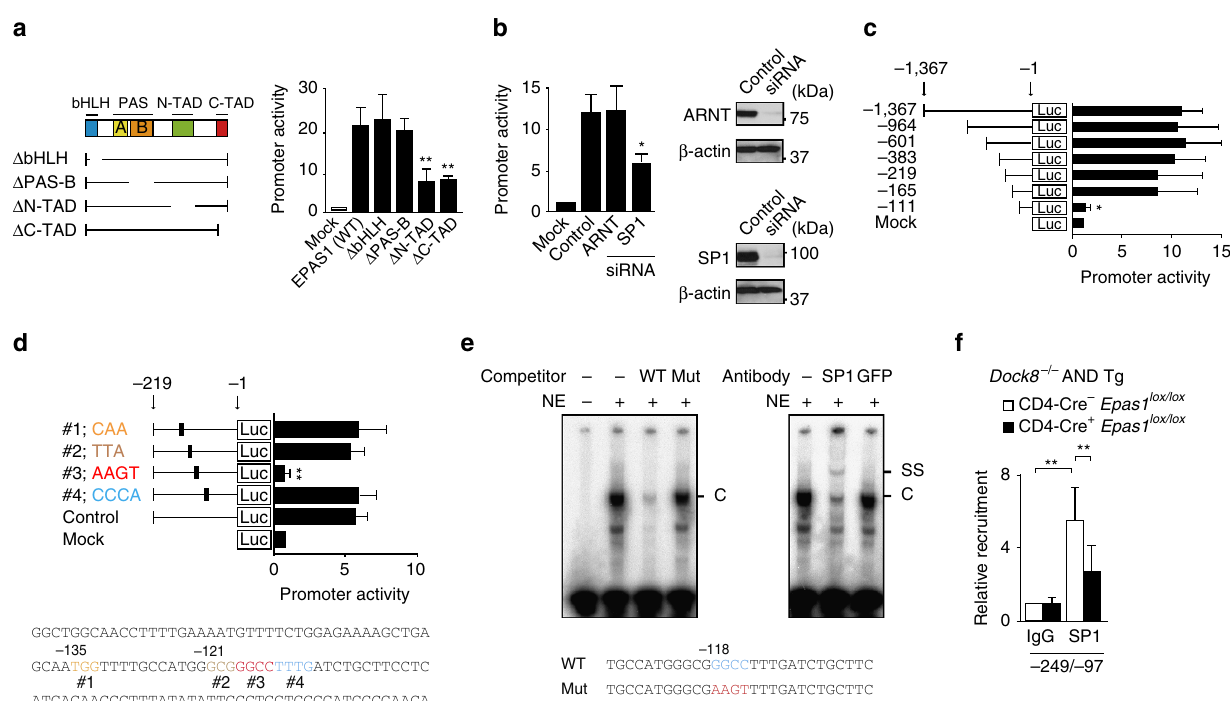
Figure 5 | EPAS1 induces Il31 promoter activation in collaboration with SP1. ( a ) EPAS1-dependent Il31 promoter activation. Schematic representation of EPAS1 mutants used in this study is shown. Data are expressed as mean ± s.d. of 5 independent experiments. ** P o 0.01 (one-way analysis of variance (ANOVA) followed by post hoc Bonferroni test). ( b ) Requirement for SP1, but not ARNT, in EPAS1-mediated Il31 promoter activation. Data are expressed as mean ± s.d. of three independent experiments. * P o 0.05 (one-way ANOVA followed by post hoc Bonferroni test). Knock down efficacy was checked by Western blot analyses. See Supplementary Fig. 11a for uncropped scans of the Westen blot. ( c , d ) Identification of the critical region of Il31 promoter for EPAS1-mediated transactivation by deletion ( c ) and site-directed mutagenesis ( d ) studies. Data are expressed as mean ± s.d. of three